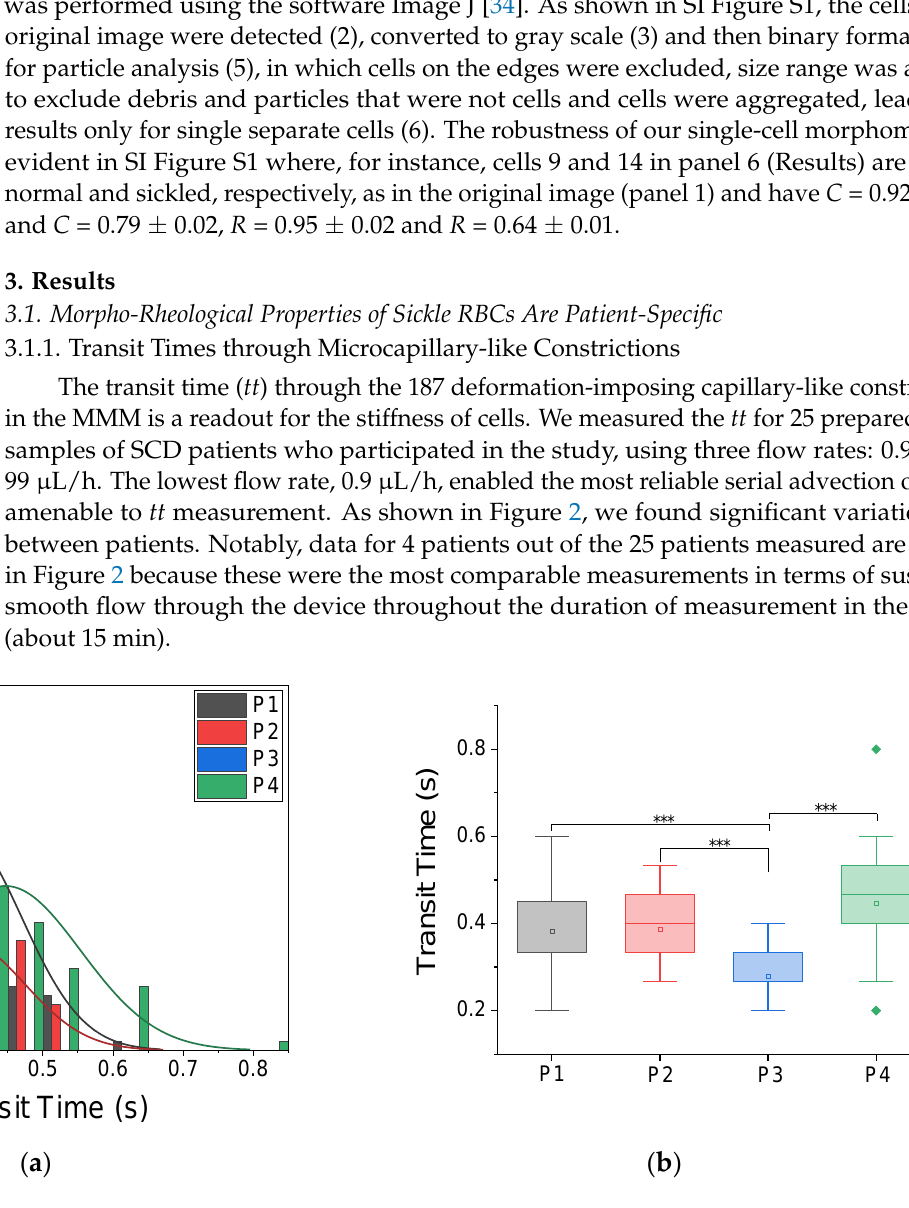
Figure 2. Transit times of RBCs in MMM vary between patients. ( a ) Histogram distribution of transit times from four patients, labeled P1, P2, P3 and P4, with normal (Gaussian) fits. The cell numbers ( n ) and mean transit times ( tt ) at a flow rate of 0.9 μL/h are: P1, n = 56, tt = 0.38 ± 0.01 s; P2, n = 50, tt = 0.39 ± 0.01 s; P3, n = 56, tt = 0.28 ± 0.01 s; and P4, n = 60, tt = 0.45 ± 0.01 s. The 5 μm MMM device was used. All given uncertainties are standard errors of the mean. ( b ) Box plots from one-way ANOVA for the transit times data in ( a ). At *** p < 0.001, there is a statistically significant difference in tt of RBCs from the four patients.